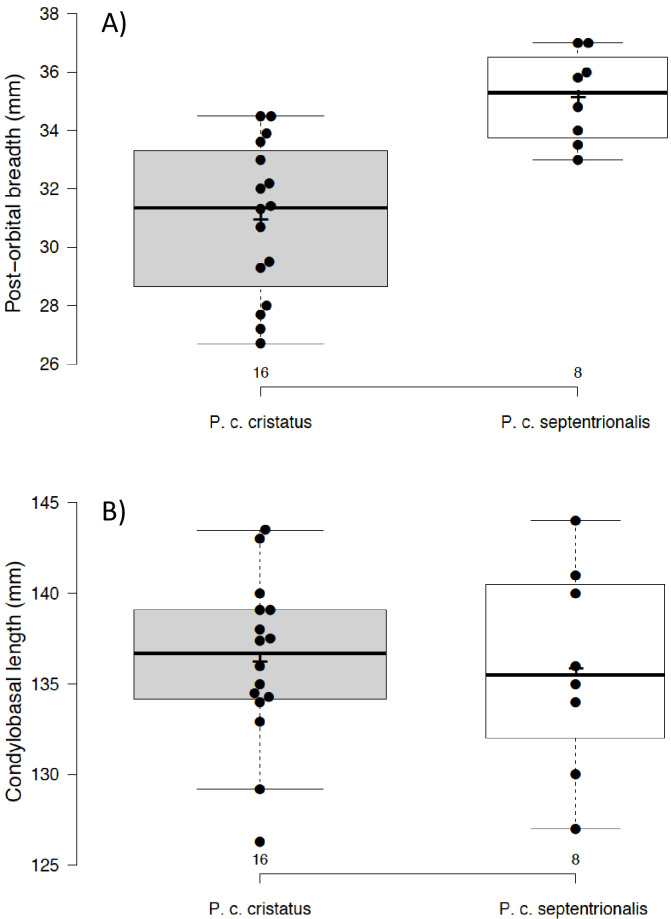
Box and jitter plot of (A) post-orbital breadths of Proteles taxa: cristatus (left) and septentrionalis (right) and (B) condylobasal lengths of skull of Proteles taxa: cristatus (left) and septentrionalis (right).Graph generated with BoxPlotR (http://shiny.chemgrid.org/boxplotr/).